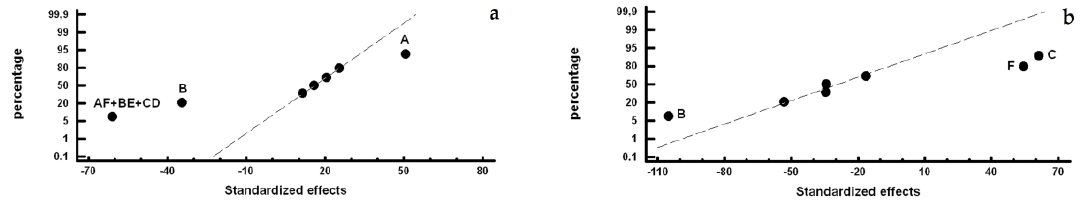
Figure 6. Representation of standardized effects on a normal probability plot versus flexural strength: ( a ) Region I and ( b ) Region II.